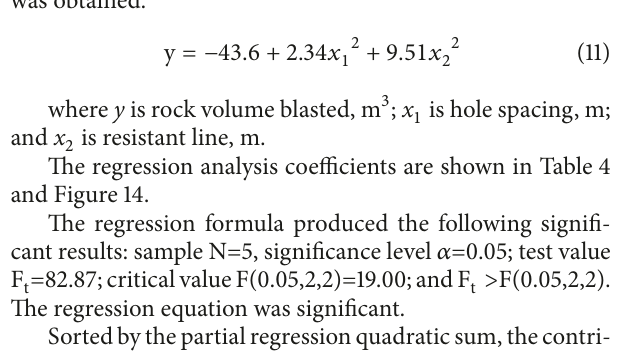
Figure 13: Blasting